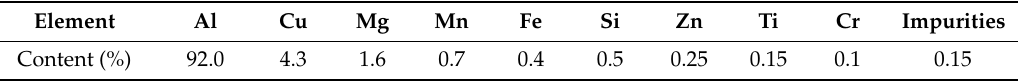
Table 1. Chemical composition of the AlCuMg2 alloy used for testing.